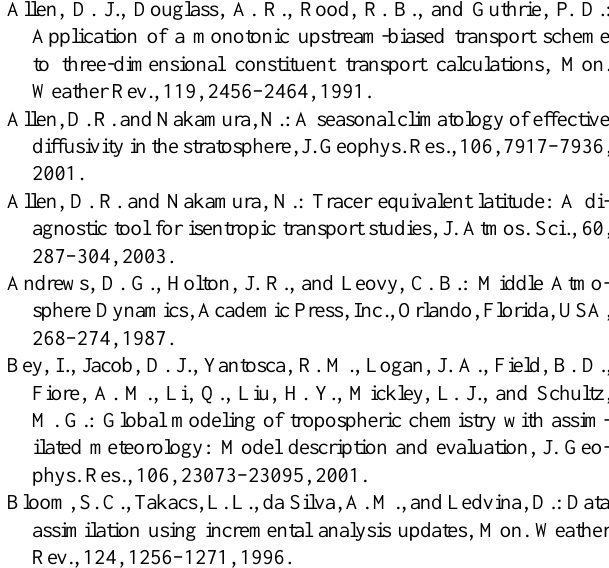
Fig. 17. Schematic diagram of an idealized passive tracer anomaly subject to linear vertical shear of the (steady) zonal wind (east (E) is to the right and Up points vertically upward in both figures). The tracer anomaly initially has a height scale D and width (in the east-west direction) H . The vertical shear is indicated by a difference in zonal wind at the bottom of the anomaly ( u 1 ) and at the top of the anomaly ( u 2 ). The top panel shows the initial tracer anomaly and the bottom panel shows the sheared tracer anomaly at time T after the top of the anomaly has completely passed the base of the anomaly. The vertical thickness of the anomaly is now D 0 .